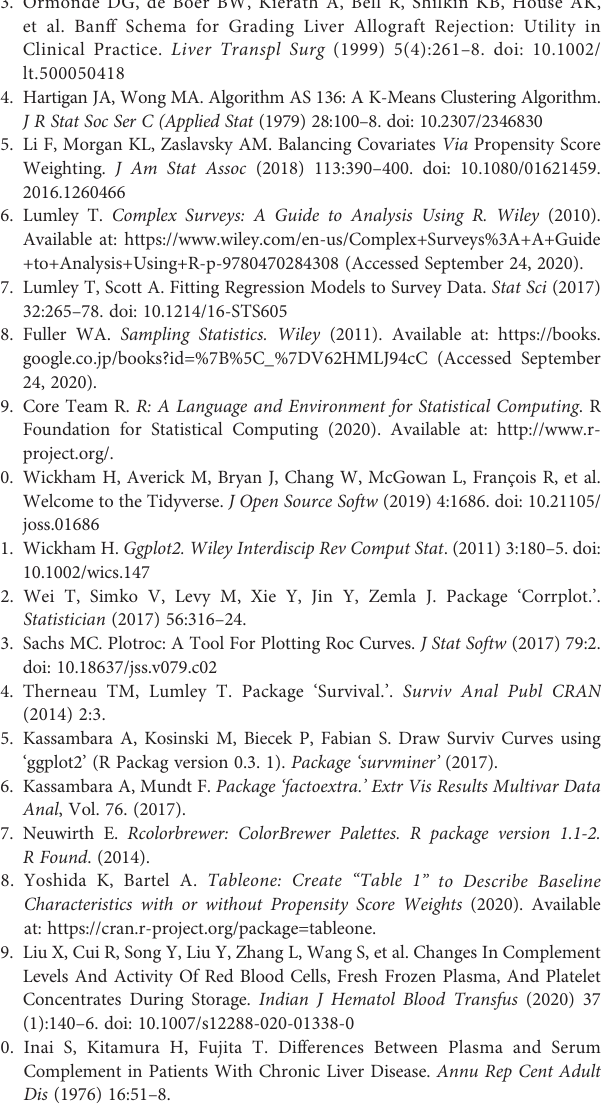
Supplementary Figure 3 | The time-dependent changes in leukocyte populations.Changesamong 4timepoints wereevaluated bytheWilcoxonsigned- rank test. *p value<0.0001. The median values and interquartile ranges are shown at each time point. Supplementary Figure 4 | (A) The two-dimensional principal component analysis using the C3, C4, and IgG levels, and the leukocyte populations at 2 weeks after LDLT, after excluding patients who underwent ABO-incompatible LDLT. The colors indicate the cluster made by k-means clustering. Circles: survivors. Triangles: non-survivors. (B) The two-dimensionalprincipalcomponent analysis using the preoperative C3, C4, and IgG levels, and leukocyte populations, after excluding patients who underwent ABO-incompatible LDLT. The colors indicate the cluster madebyk-meansclustering.Circles:patientswithout